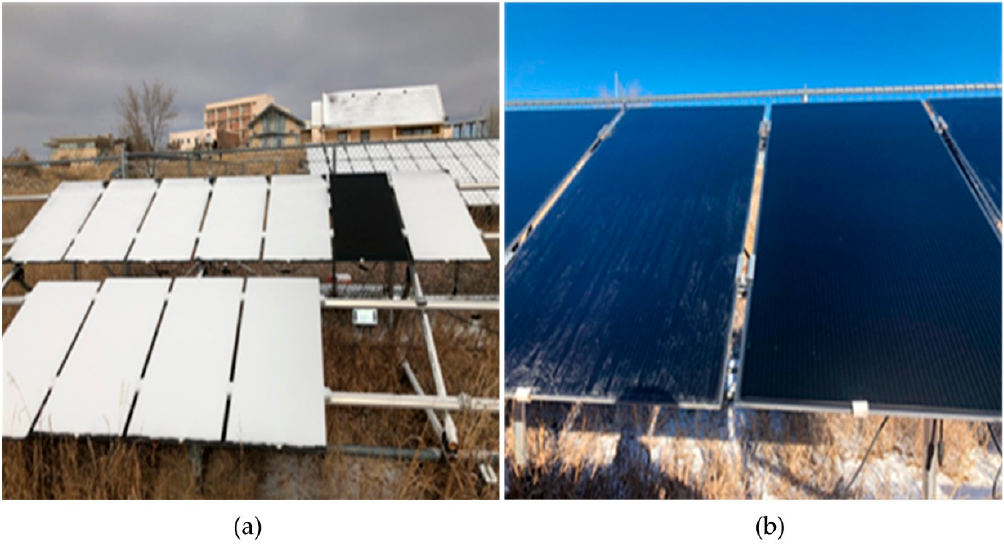
Figure 2. ( a ) The black panel was coated with a hydrophobic coating (coating A) and continued to produce power after snowfall. All other panels were covered in snow. ( b ) Following the snow melt, residues were deposited on the uncoated panel ( left ), while the coated panel ( right ) remained clean. The anti-soiling effect gradually degraded over a few weeks.